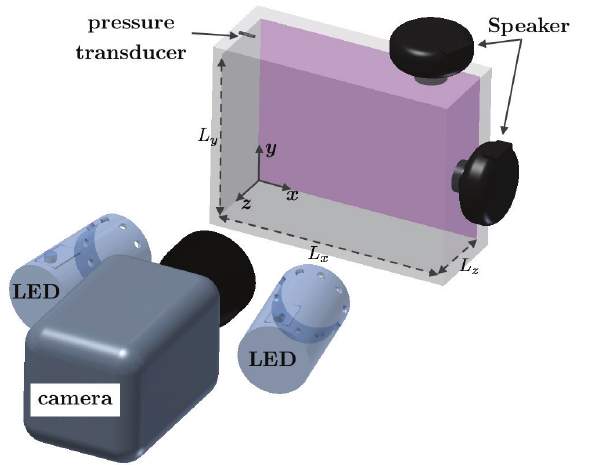
Figure 2. Acoustic box with